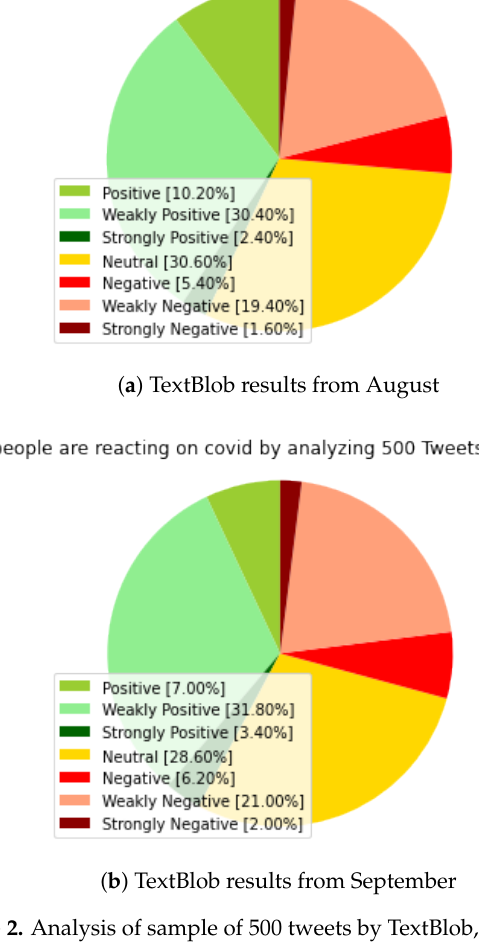
Figure 2. Analysis of sample of 500 tweets by TextBlob, using “COVID” keyword. The time periods stands between 29 August 2021 and 31 August 2021, and 2 September 2021 and 4 September